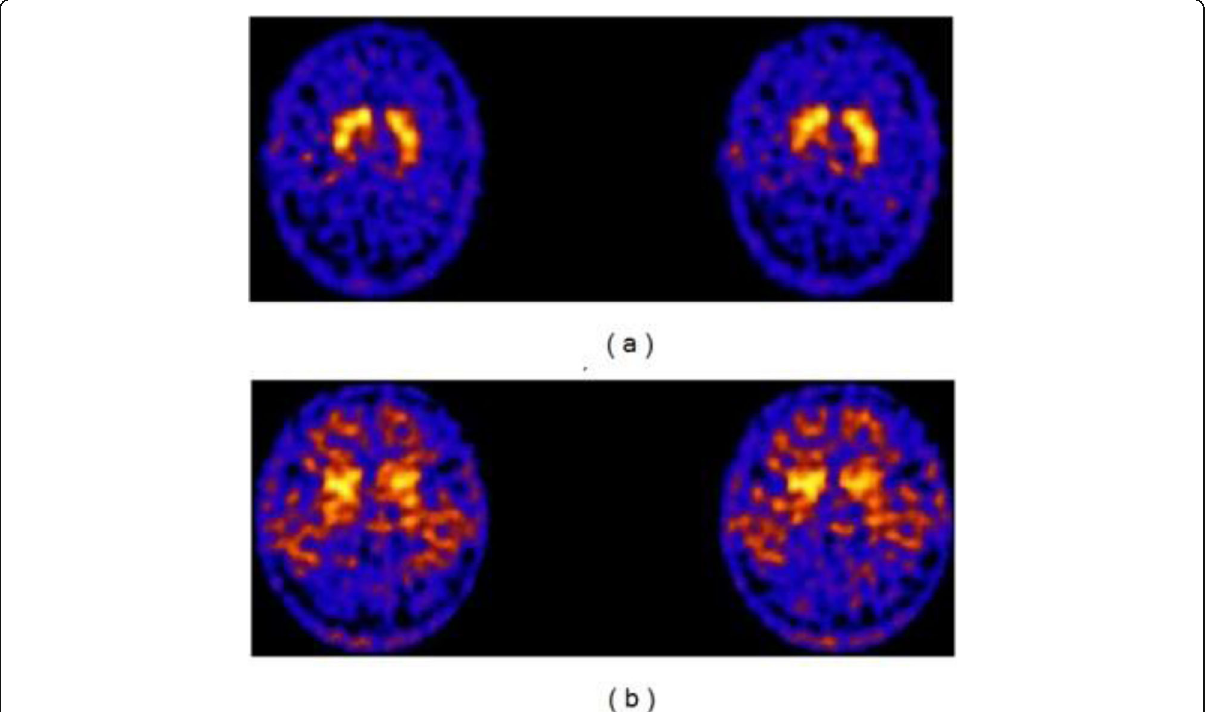
Fig. 6 SPECT imaging using 99m Tc-TRODAT-1 in normal control ( a ) and patient with early PD ( b ). In the case of patient with early PD in comparison to control, images show reduced TRODAT-1 uptake in the striatum